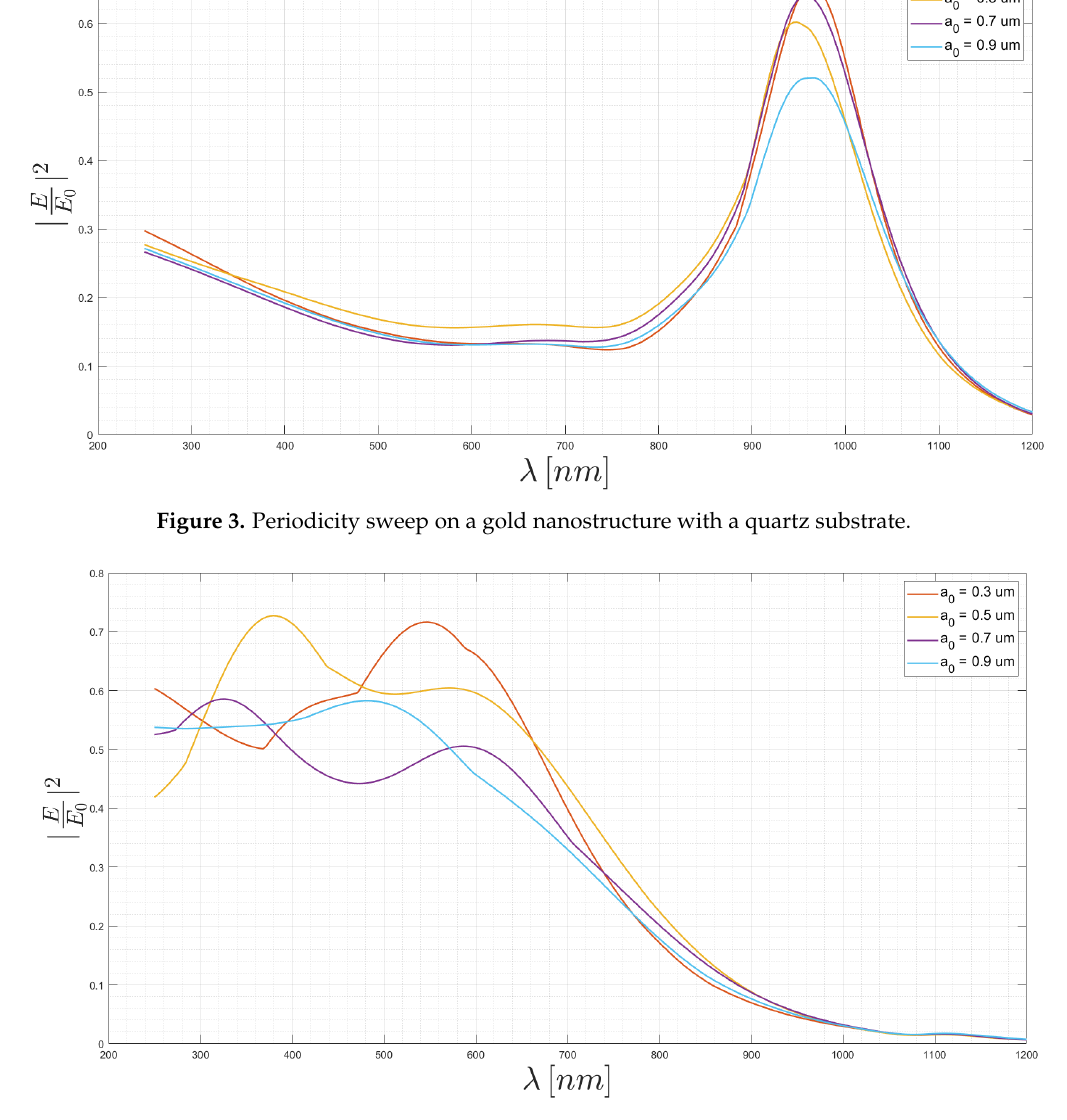
Figure 4. Periodicity sweep on an aluminum nanostructure with a quartz